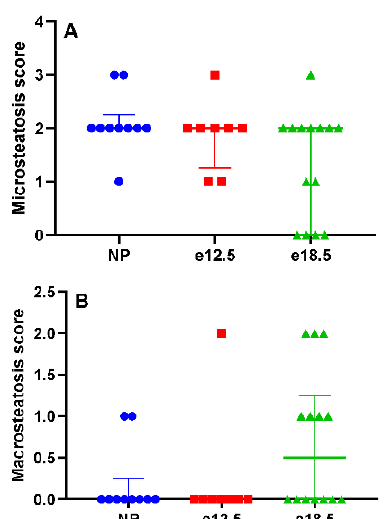
Figure 3. Histologic hepatic steatosis scores in NP, e12.5, and e18.5 BPH/5 mice ( n = 8–15 per group). ( A ) A score of 0 equates to no microsteatosis observed, and 3 is severe. Microsteatosis was observed at all time points. There was no significant difference between groups. ( B ) A score of 0 equates to no macrosteatosis observed, and 3 is severe. Macrosteatosis scores increased in a subset of mice at e18.5. There was no significant difference between groups.